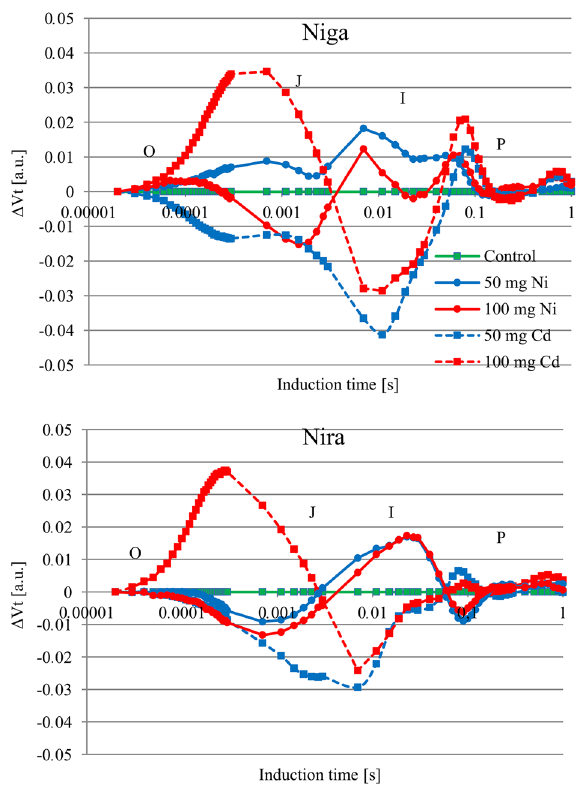
Figure 2. Differential curves of ΔV t [relative units, obtained by subtracting control curve from the first sample] of two perennial ryegrass turf cultivars (‘Niga’ and ‘Nira’) under different Ni and Cd treatment (0; 50 and 100 mg × 100 g −1 of substrate) (n =